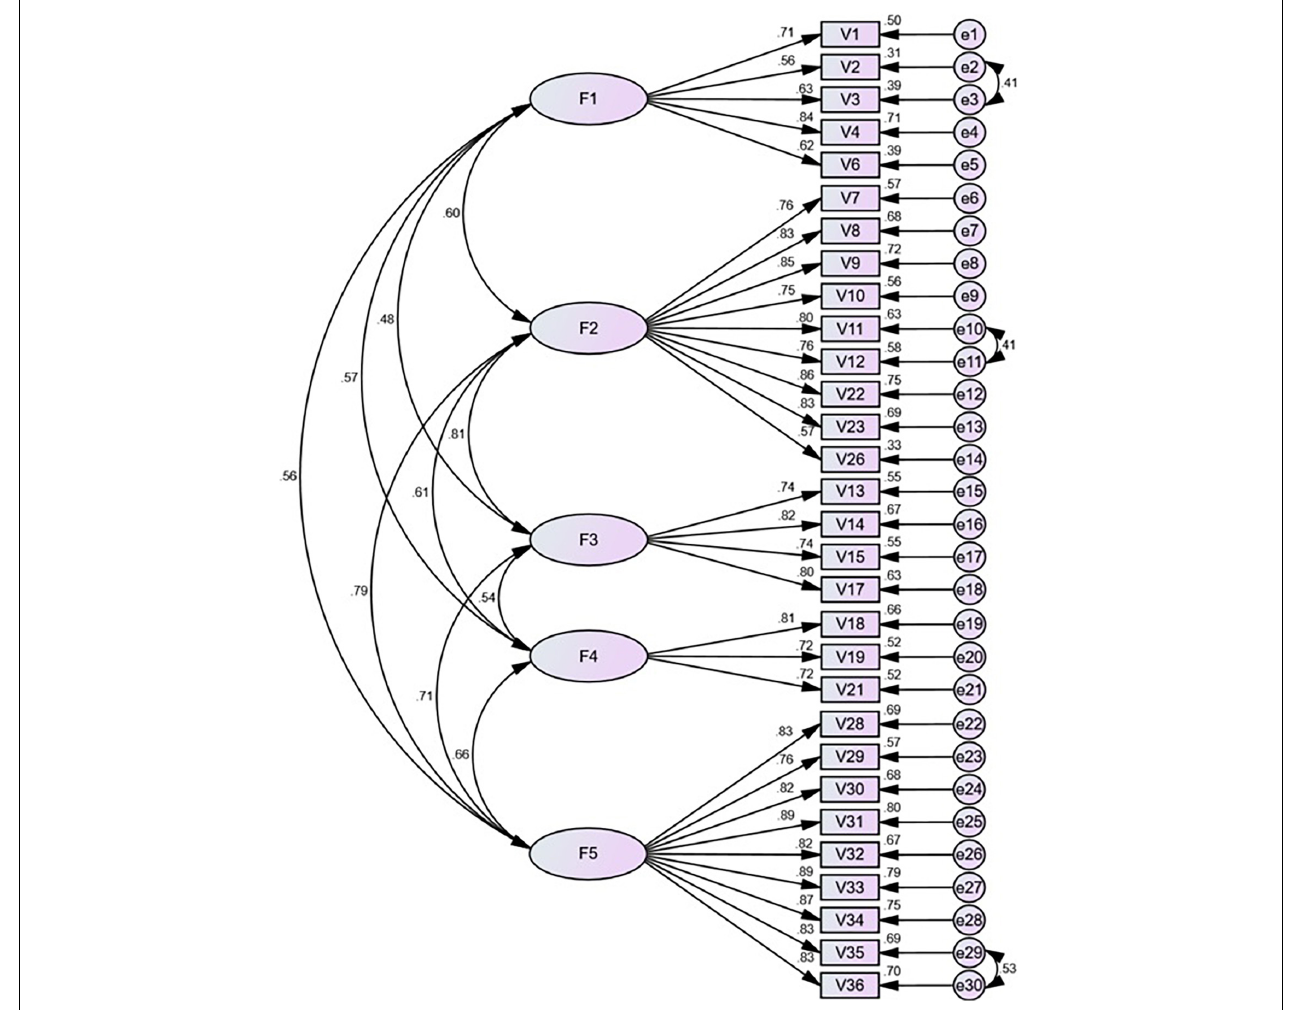
FIGURE 3 | Standardized five-factor structural model for the China Revision of the Pitt Wellness Scale ( n = 906, 30 items). F1 (Physical domain), F2 (Mental and Spiritual domain), F3 (Social domain), F4 (Financial domain), F5 (Occupational and intellectual domain) (We named Factor 2 as the psychological domain and Factor 5 as the competent domain. See the discussion section for more